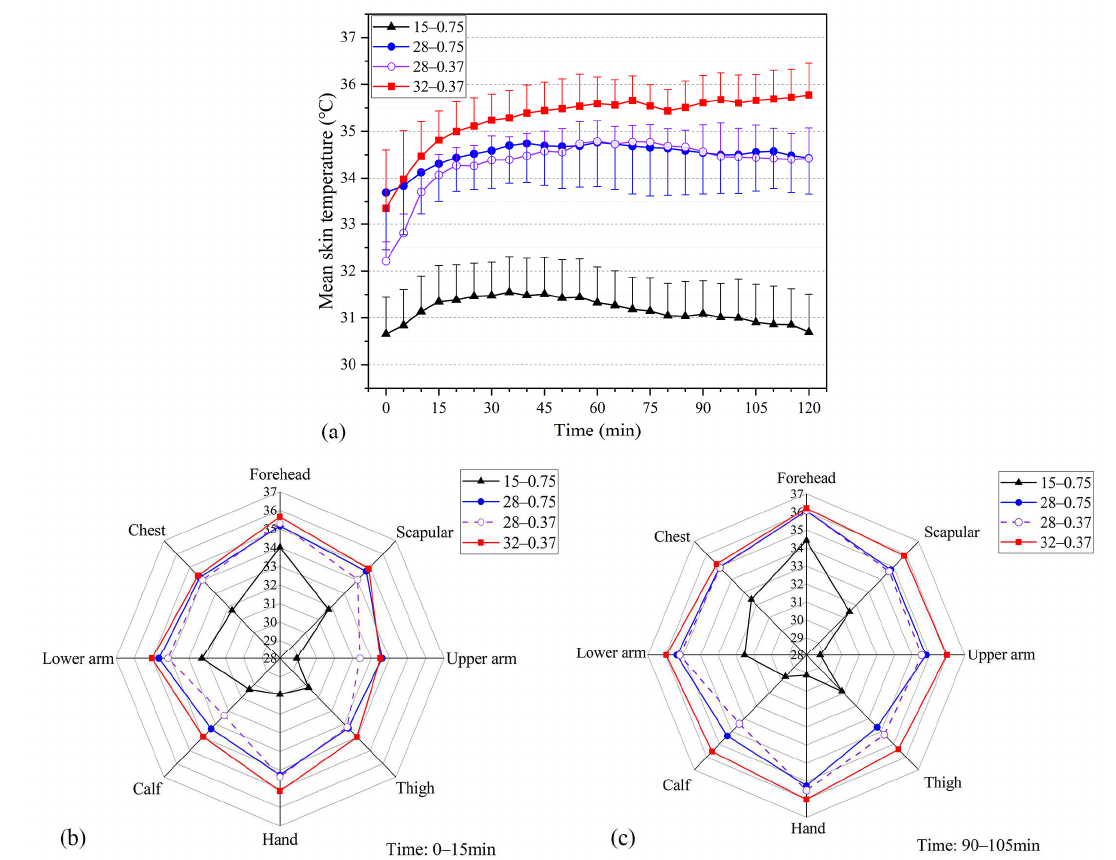
Figure 4. Skin temperature responses under four testing scenarios (i.e., 15 ◦ C–0.75 clo, 28 ◦ C–0.75 clo, 28 ◦ C–0.37 clo, 32 ◦ C–0.37 clo; testing scenarios in the figures are presented as A–B, where A represents the WBGT value and B represents the insulation of the inner garments used in the testing). ( a ) Mean skin temperatures. ( b ) Local mean skin temperatures at 0–15 min. ( c ) Local mean skin temperatures at 90–105 min.